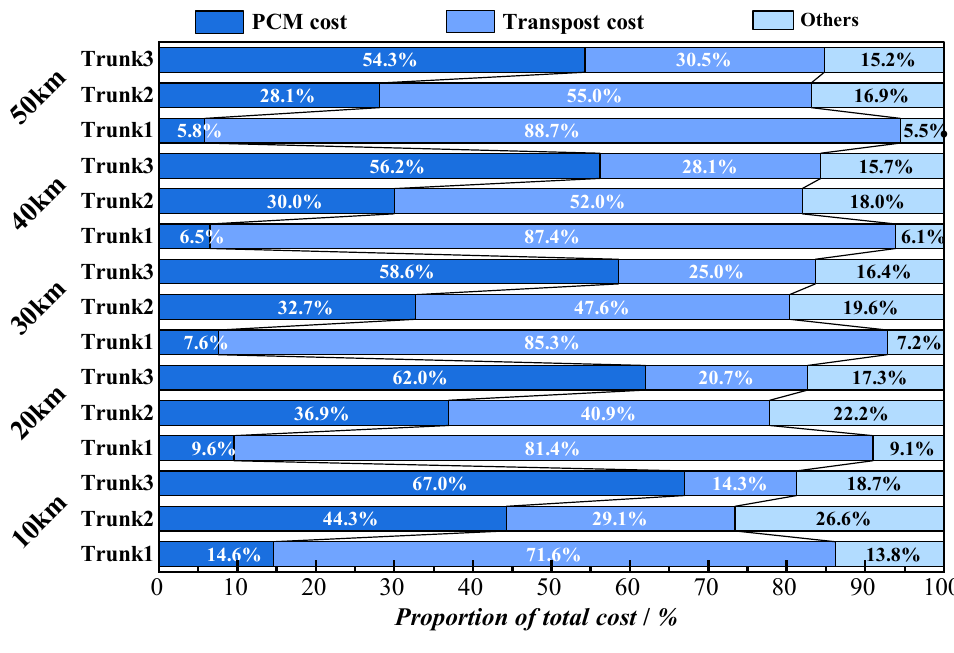
Figure 9. Proportion of total cost.